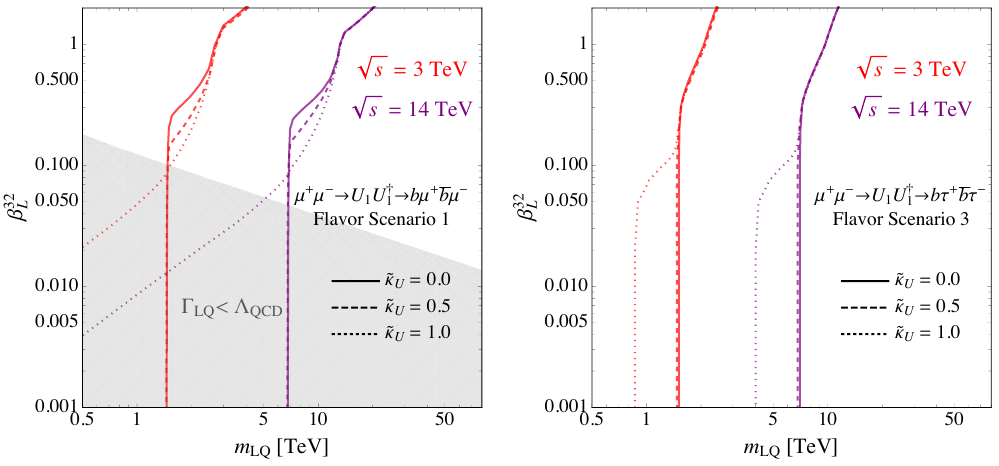
√ s = 3 or 14 TeV muon collider via pair